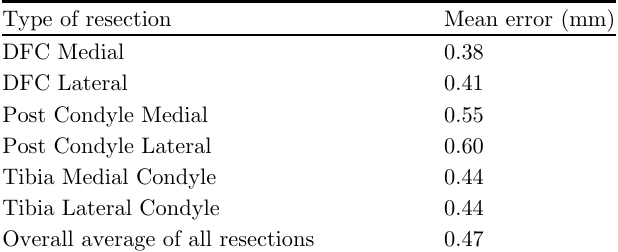
Table 3. Mean errors of different bone resections. The bar graph represents the mean error recorded in each of the different bone resections recorded, namely Distal Femur Medial Condyle, Distal Femur Lateral Condyle, Posterior Condyle Medial, Posterior Condyle Lateral, Tibial Medial Condyle, Tibial Lateral Condyle. The lowest error was recorded in Distal Femur Medial Condyle at 0.38mm and highest was in Posterior Condyle Lateral at 0.60mm.